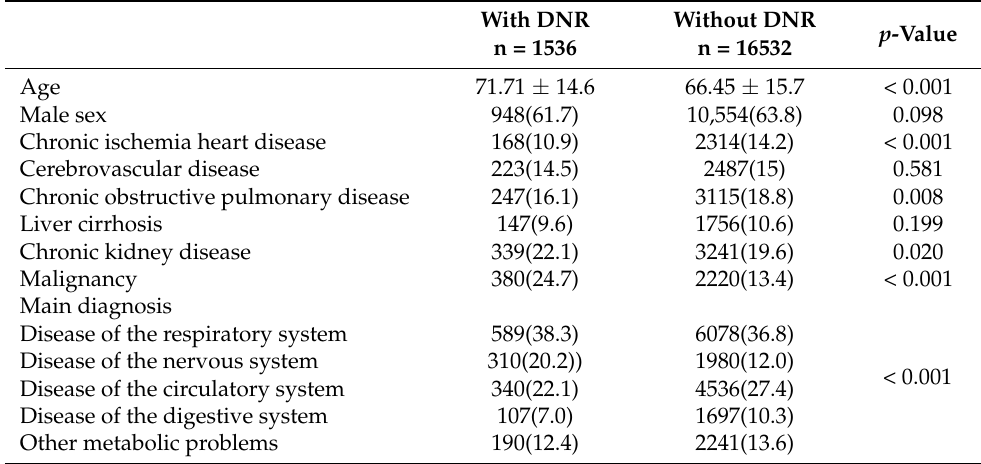
Table A1. Clinical characteristics of patients.